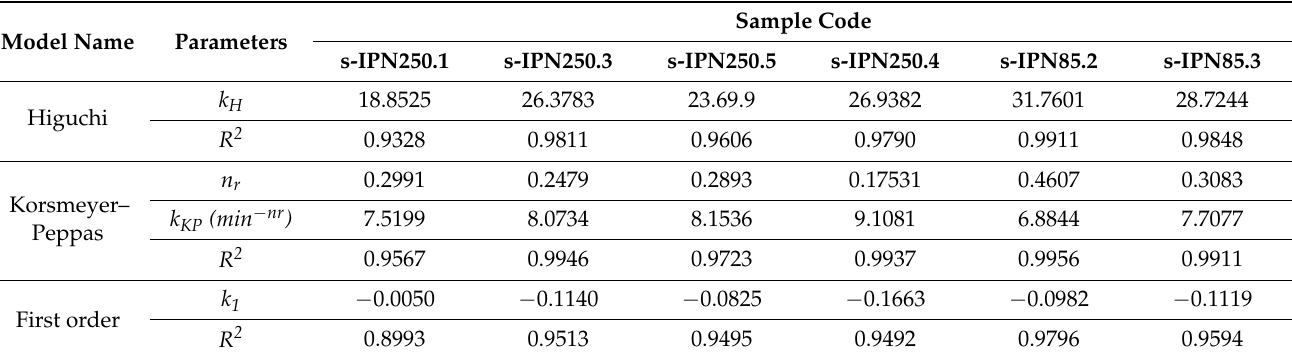
Table 5. Kinetic parameters for the release of CCM from semi-IPN PAAm/PDMAEMA